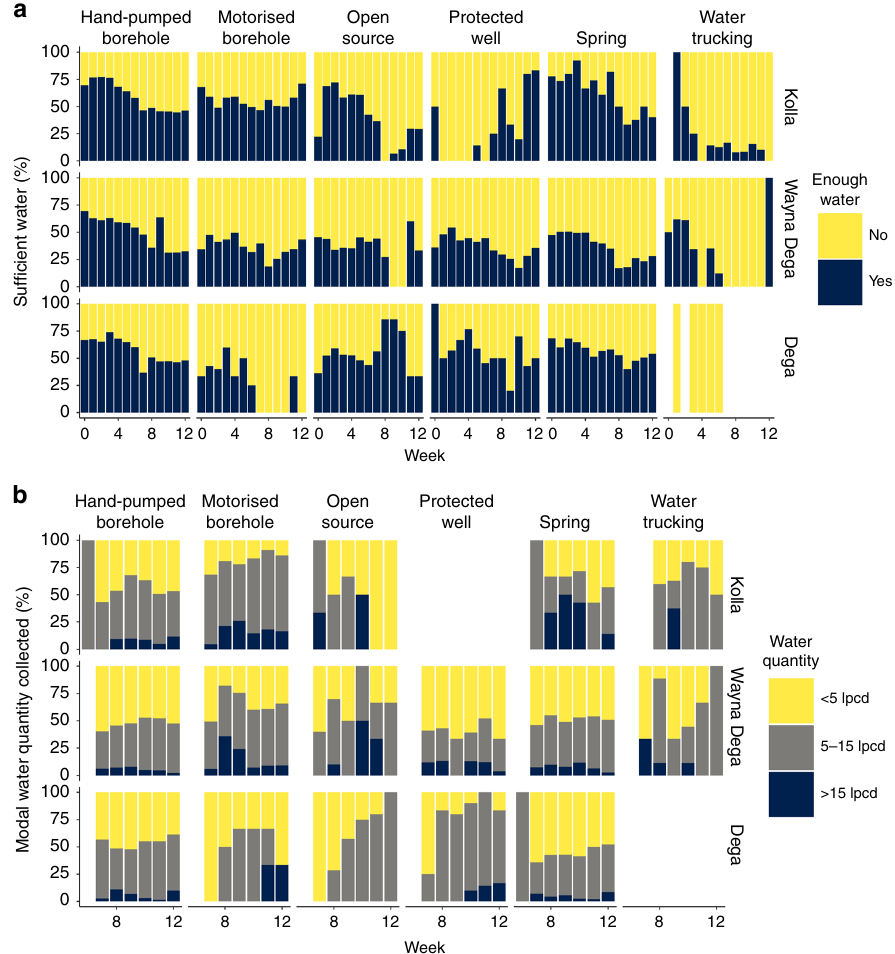
Fig. 6 Reported perceptions of water quantity by water source type. a Users perception of water quantity and b reported water quantities in litres per capita per day (lpcd), based on a household survey conducted from week 7 to the end of the monitoring period, in Ethiopia ’ s three main altitude zones for each water source type. Supplementary Figures 9 and 10 provide details on the numbers of each source type visited in each region and for which water quantity data is